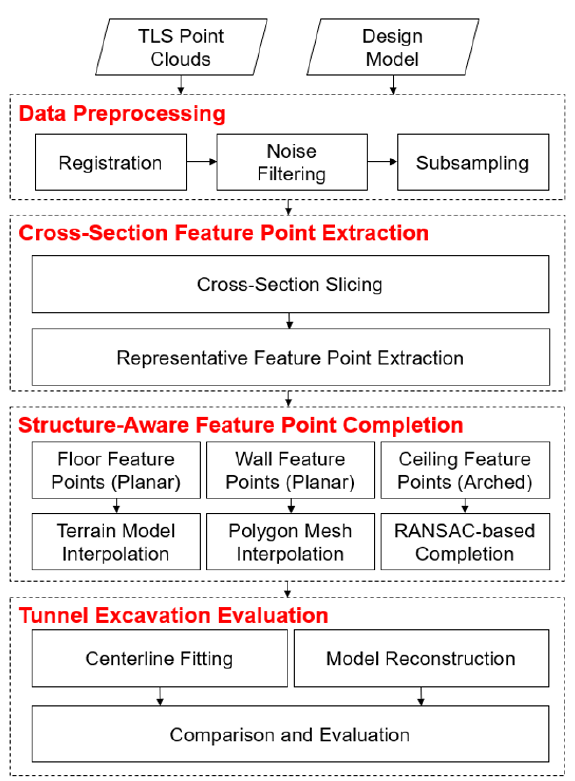
Figure 2. Overview of the proposed